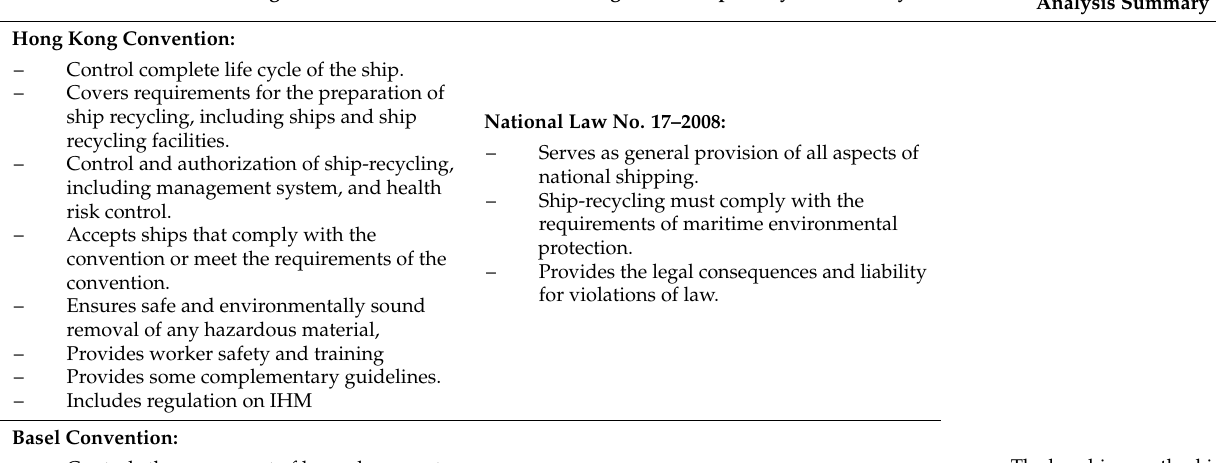
Table 2. Gap analysis